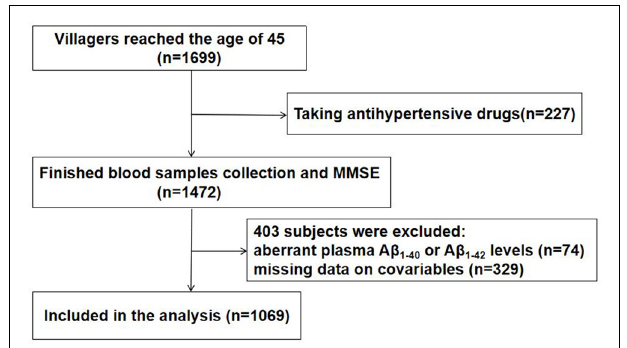
FIGURE 1 | Flow chart of participant selection. A β , amyloid- β